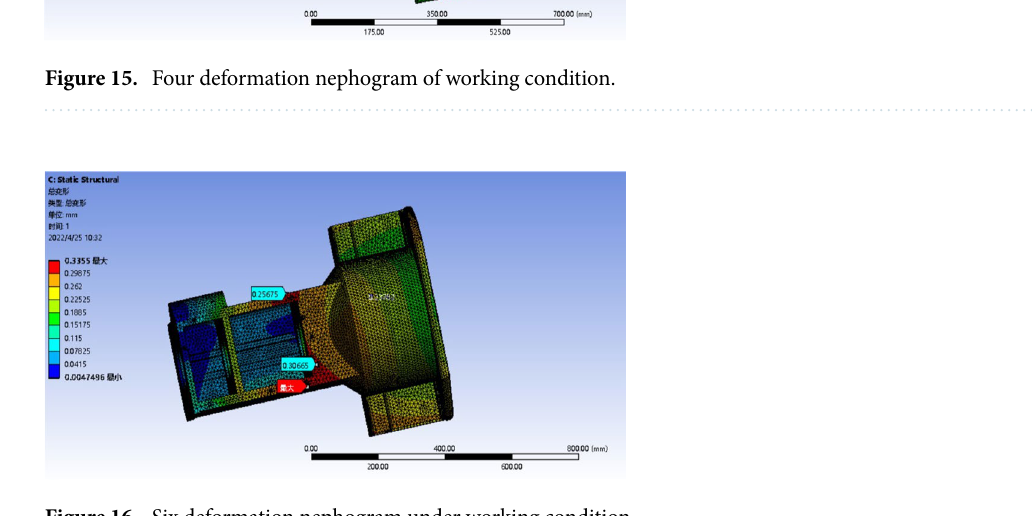
Figure 16. Six deformation nephogram under working